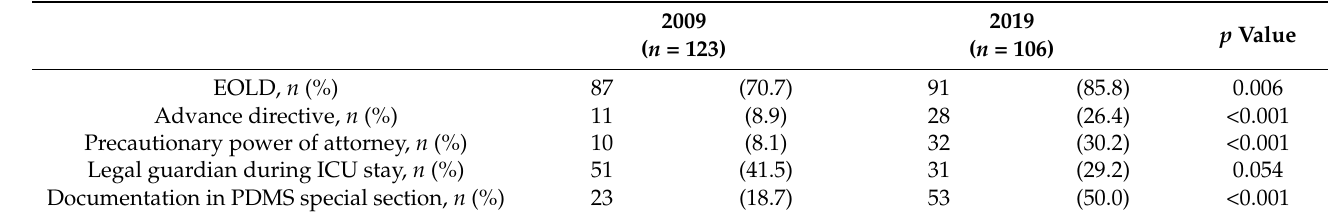
Table 3. Prevalence of EOLD and patient advance directives.